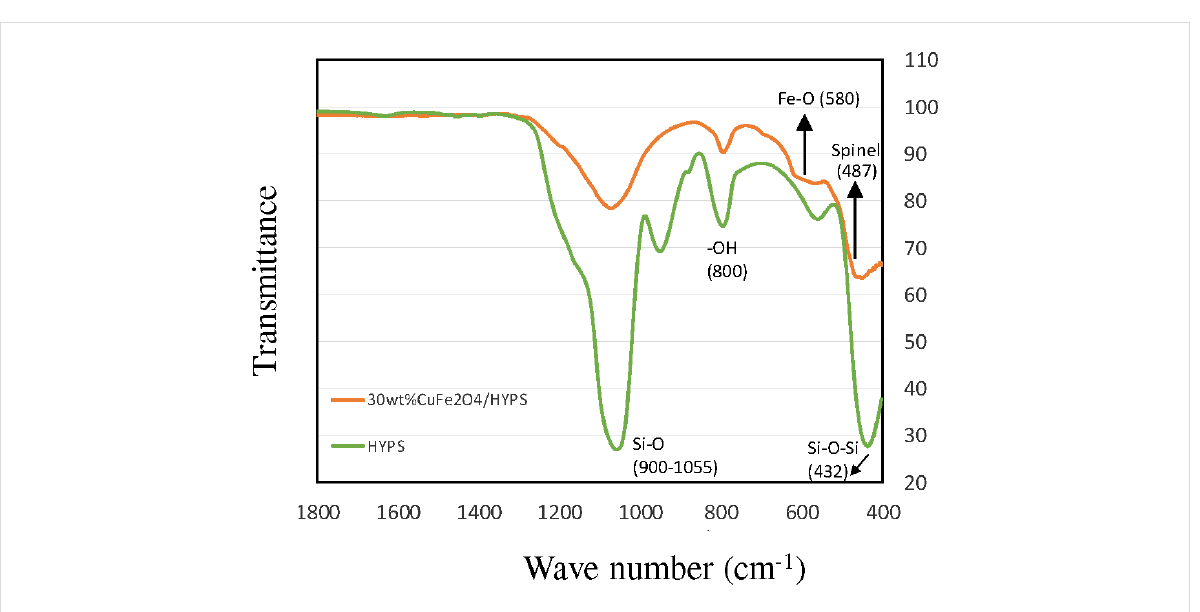
Figure 3: FTIR spectra of HYPS and 30 wt % CuFe 2 O 4